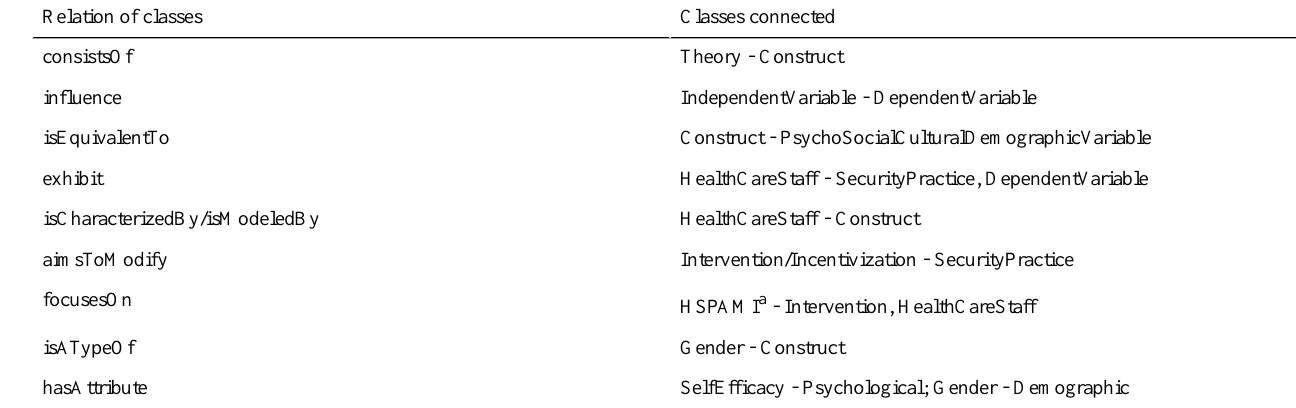
Table 6. Relation of